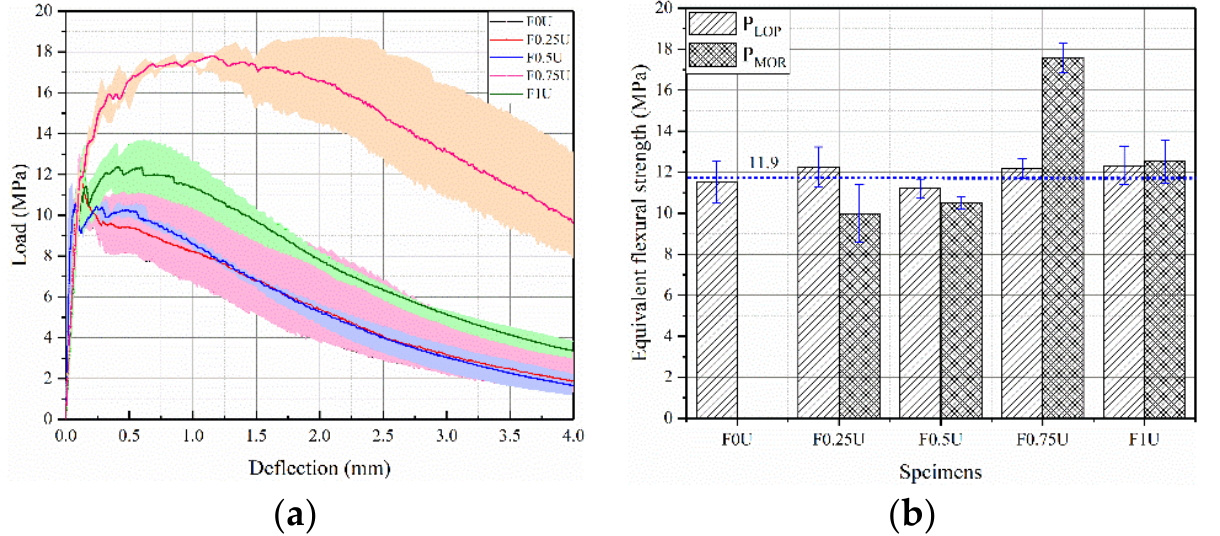
Figure 5. Load – deflection curves ( a ) and equivalent flexural strength ( b ) of specimens. Figure 5. Load-deflection curves ( a ) and equivalent flexural strength ( b ) of